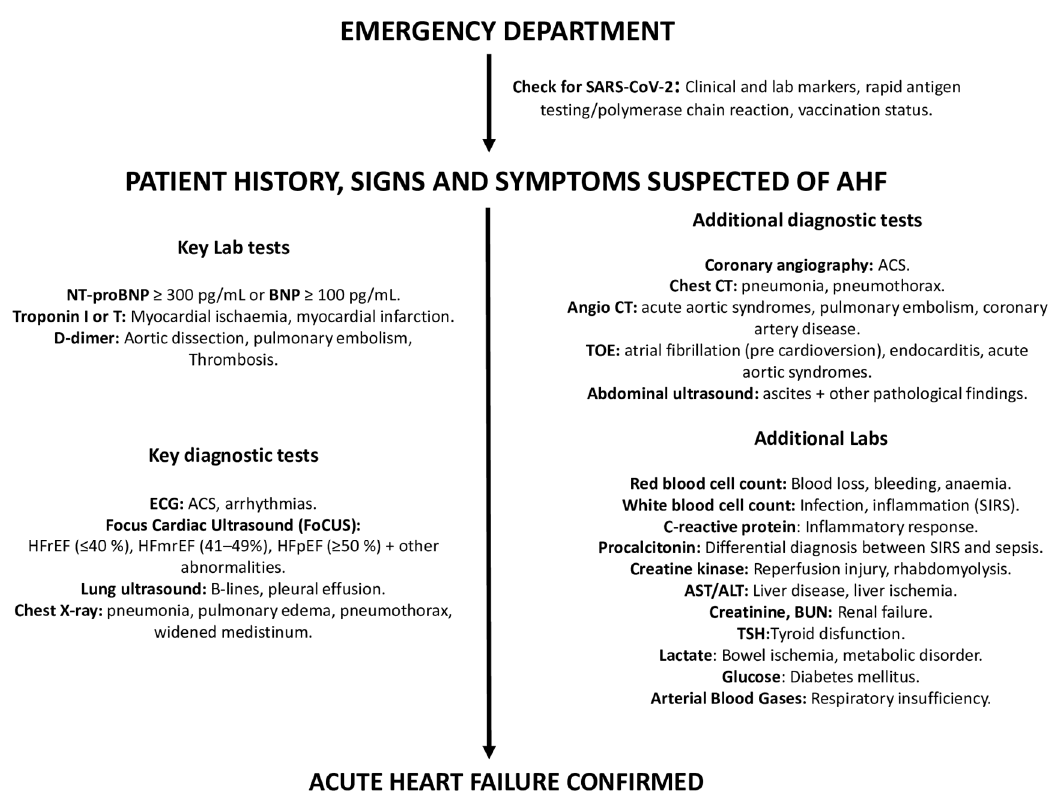
Figure 2. Diagnostic workup of AHF. Abbreviations: ACS: acute coronary syndrome; ALT: alanine aminotransferase; AST: aspartate aminotransferase; BUN: blood urea nitrogen, BNP: brain natriuretic peptide; CT: computed tomography; ECG: electrocardiogram; TOE: transesophageal echocardiogram; TSH: thyroid-stimulating hormone. Table 2. Triggers of AHF.